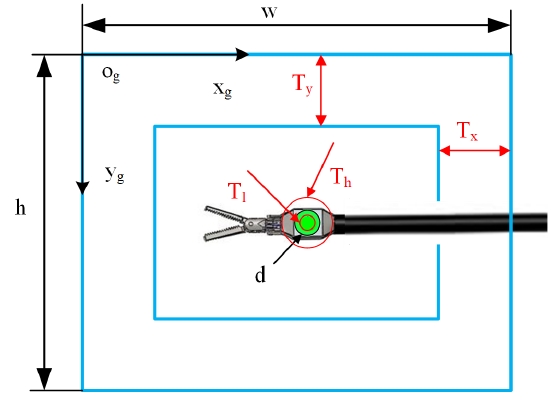
Figure 4. Threshold setting.